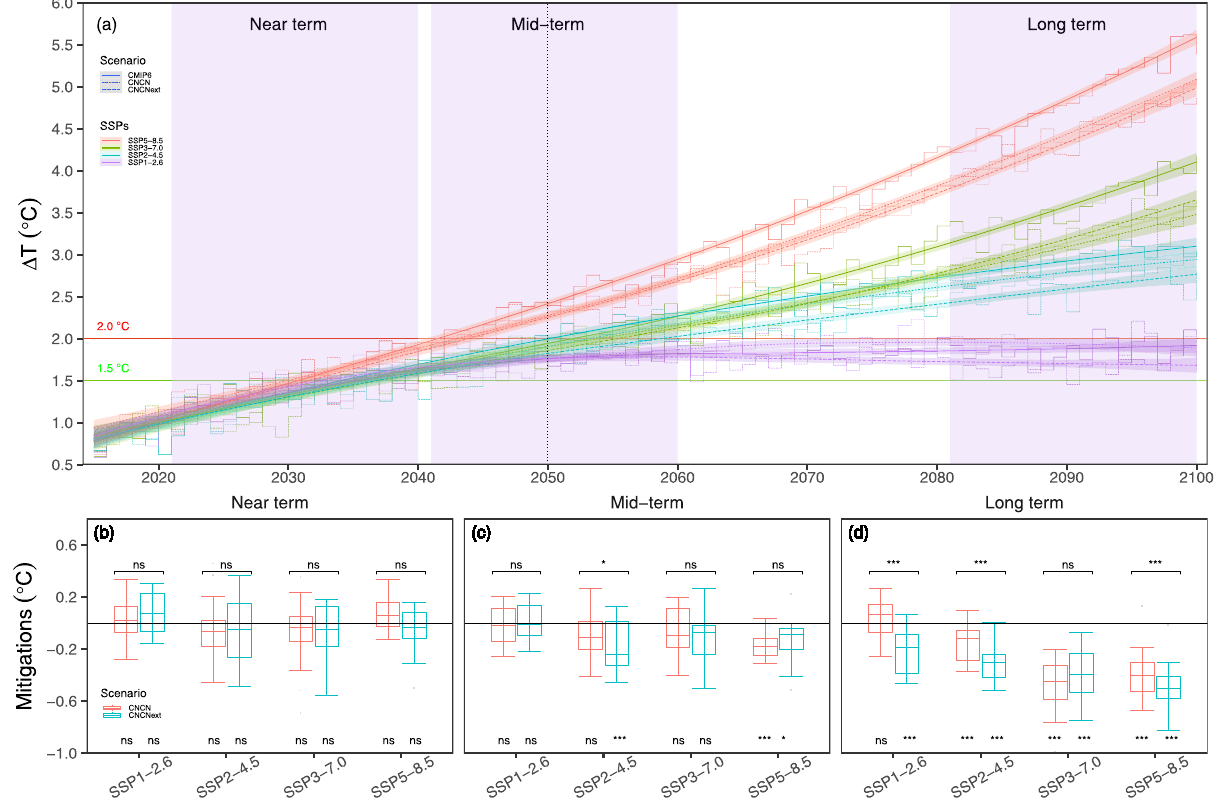
Fig.1|MitigationsofChina ’ scarbonneutrality(CNCN)andextensionscenarios with additional CH 4 and NO 2 emission reductions accompanied by the CO 2 emission reductions for CNCN (CNCN ext ) to global mean surface temperature (GMST). a Evolution of GMST changes relative to the preindustrial period (1850 – 1900 average) ( Δ T, unit in °C) for the default CMIP6, CNCN and CNCN ext scenarios from 2015 to 2100. b – d represent mitigations of the CNCN and CNCN ext scenarios for each shared socioeconomic pathway (SSP) over the near term (2021 – 2040), mid-term (2041 – 2060) and long term (2081 – 2100). The mitigation effect is calculated as the difference in GMST between the CNCN (or CNCN ext ) and the default CMIP6 scenarios. The segment lines represent the